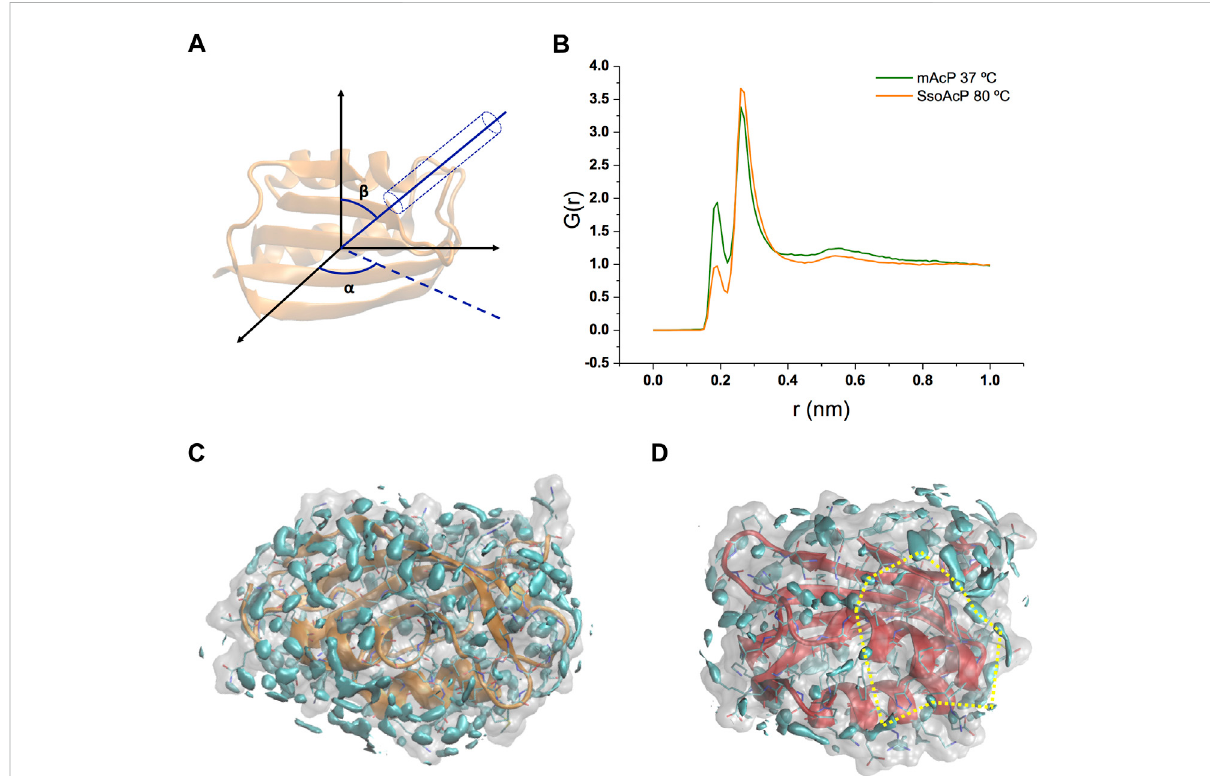
Structural properties of waters in the hydration shells of mt AcP and Sso AcP . (A) Schematic representation of the water radial distribution function G(r) calculation. A cylinder of 4 Å diameter was oriented by scanning the two Eulerian angles, α and β , with astep size of 20 ° . For each water moleculeinthecylinder,thedistancefromtheproteinsurfacewasusedtocalculatetheG(r).Thefunctionwasaveragedacrossthevaluesof α and β , and the simulation frames. (B) G(r) of mt AcP (orange) and Sso AcP (green). (C,D) Water density maps of mt AcP at 37 ° C (C) and Sso AcP at 80 ° C (D) contoured by cyan surfaces enclosing regions with a value of water density 2.0 times higher than the bulk average density. The density maps provide thelocation ofthe MDHS around theproteinsurface, which are de fi ned as local maxima of thefunction in aradius of 0.14 nm, following the restriction to possess a minimum density of 2.0 times the value of the bulk water. In SsoAcP , large surfaces lacking MDHS were observed. One of these regions is highlighted using dotted yellow lines as an